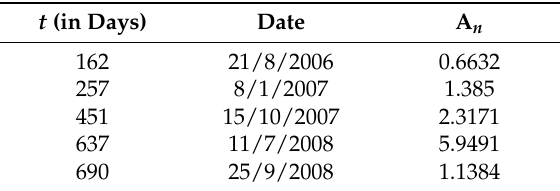
Table 17. Change points for Microsoft with the corresponding test statistic value.